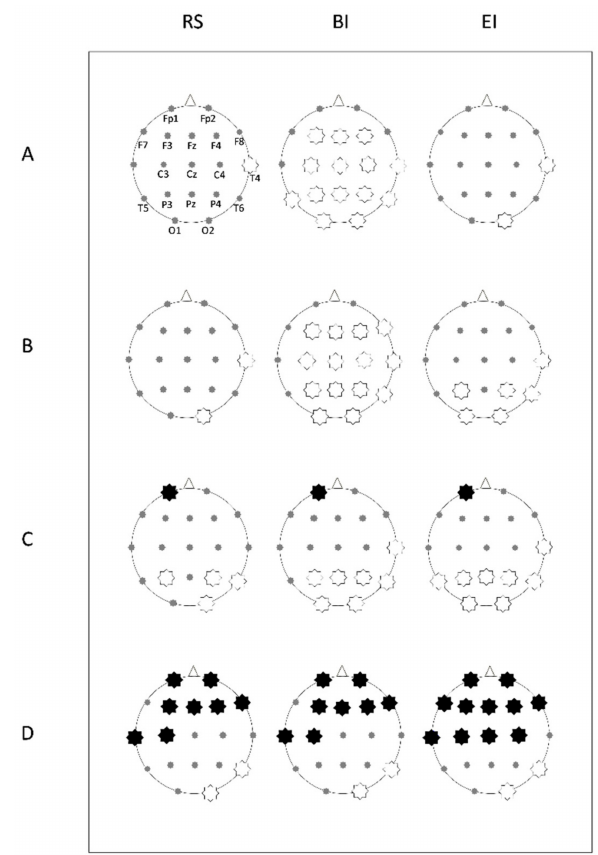
Figure 2. Probability maps for post-hoc power di ff erences between groups in each studied EEG band, during rest (RS), begin interval (BI) and end interval (EI) of exploration. A star corresponding to an electrode of the 10-20 system indicates a statistically significant di ff erence ( P < 0.01): a white star indicates lower power in the obese (OBS), while a black star indicates higher power in OBS. ( A ) theta, ( B ) alpha, ( C ) beta, ( D ) gamma